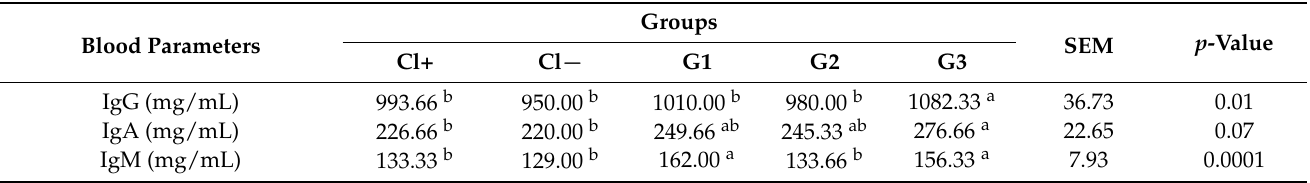
Figure 2. The small intestines of all groups show significant changes (Table 8 and Figure 2A). There were improvements ( p < 0.05) in the small intestinal wall (intestinal layers from mucosa, submucosa, mucosa and serosa) of the groups receiving the fortified yogurts (G1, G2 and G3). The improvements ( p < 0.05) in the small intestinal wall caused an increase of villus width (VW), villus length (VL), goblet lining cells (G Cell) and muscle thickness (MTh). However, the highest value ( p < 0.05) was detected in Cl − for the number of villin